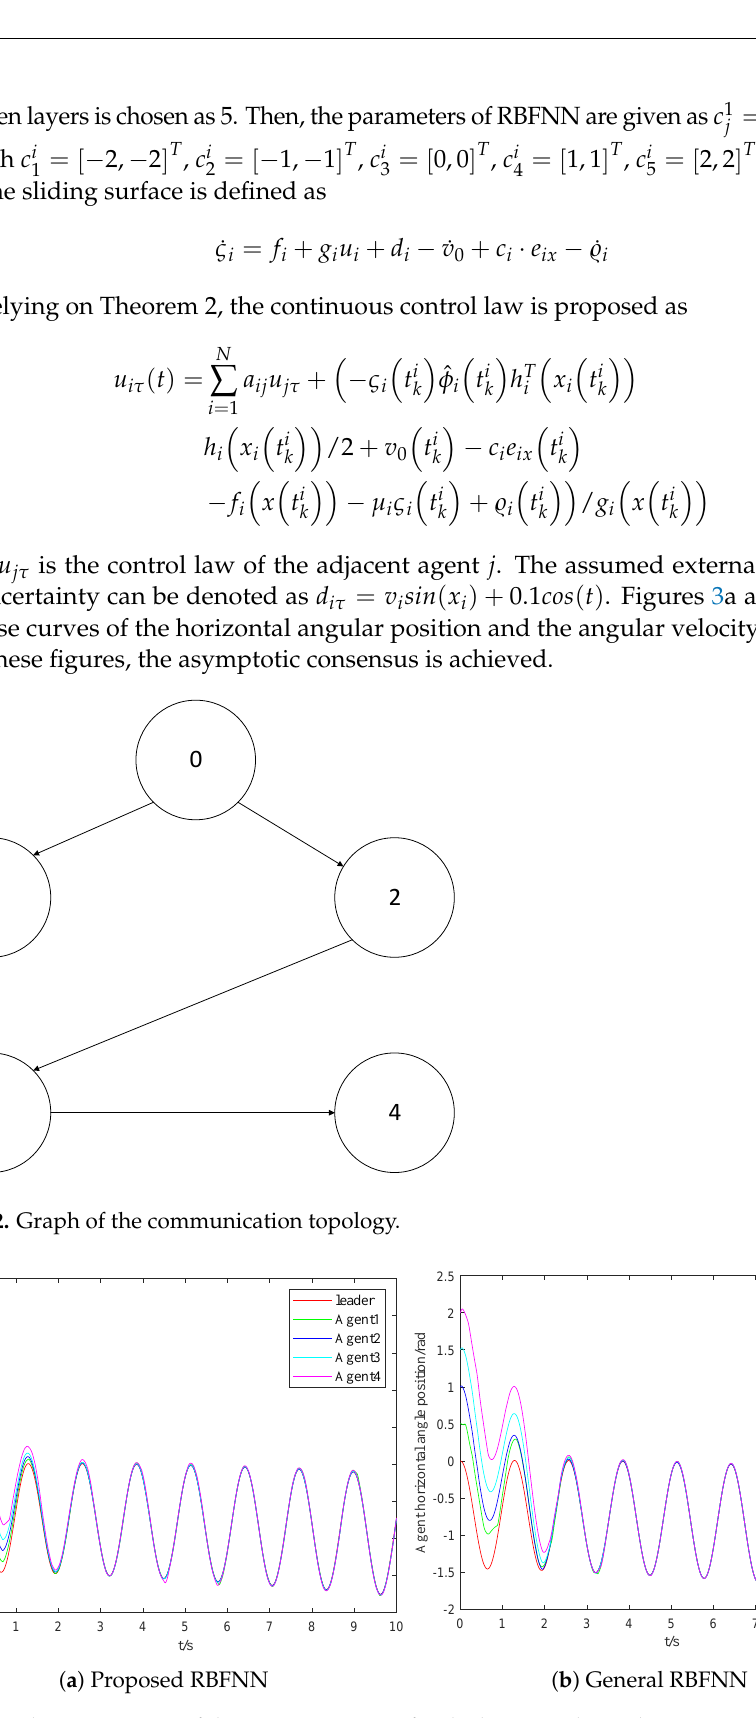
Figure 3. The comparison of the response curves for the horizontal angular